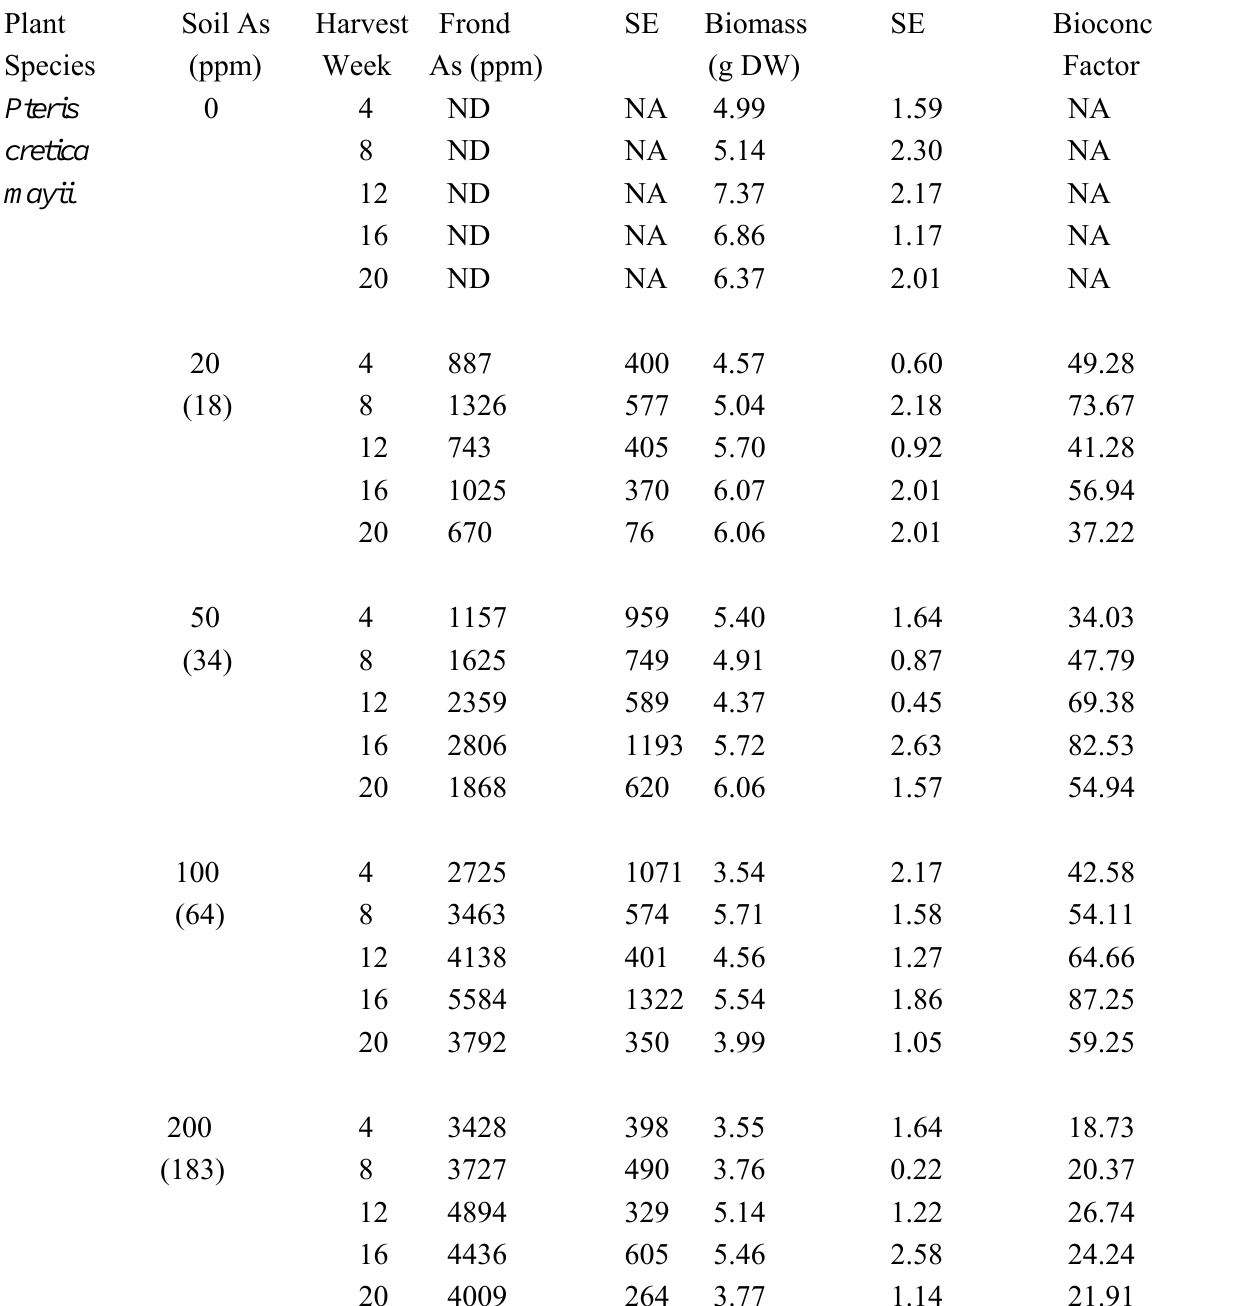
Table 2. Summary Results for arsenic uptake in Pteris cretica mayii. SE is the standard error. Soil As lists predicted concentration and actual concentration in